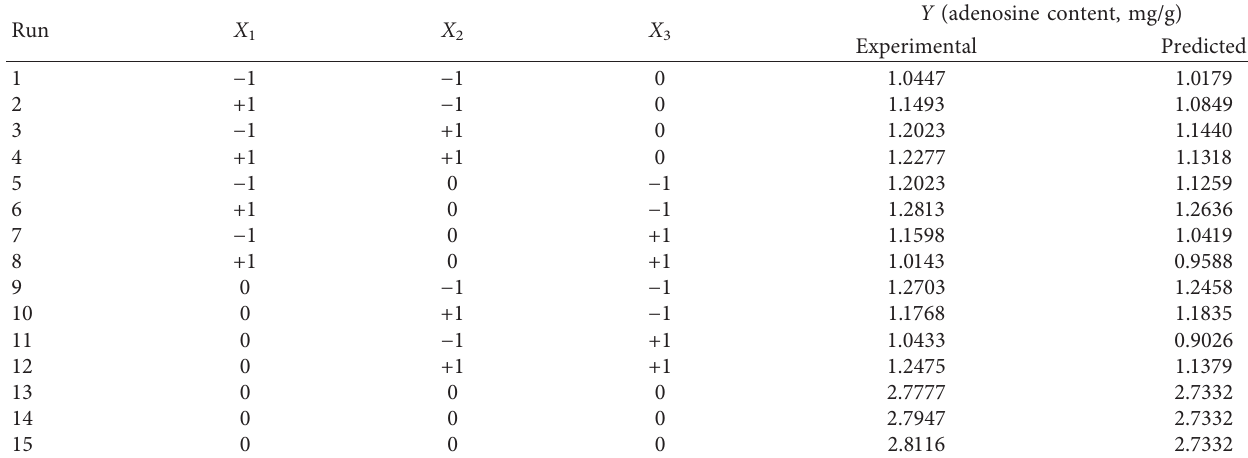
Table 2: Box-Behnken experimental design and observed